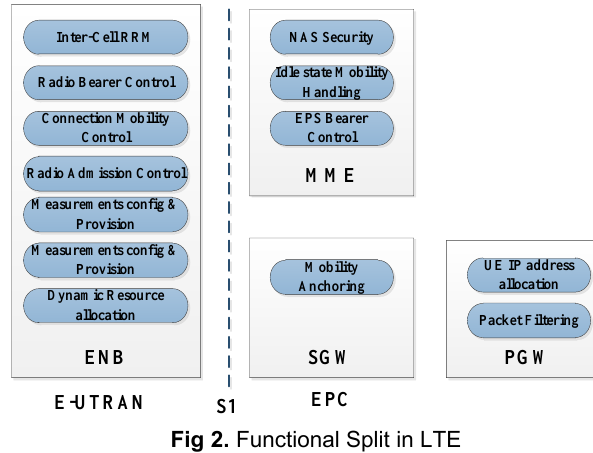
Fig. 1. Functional Split in 5G